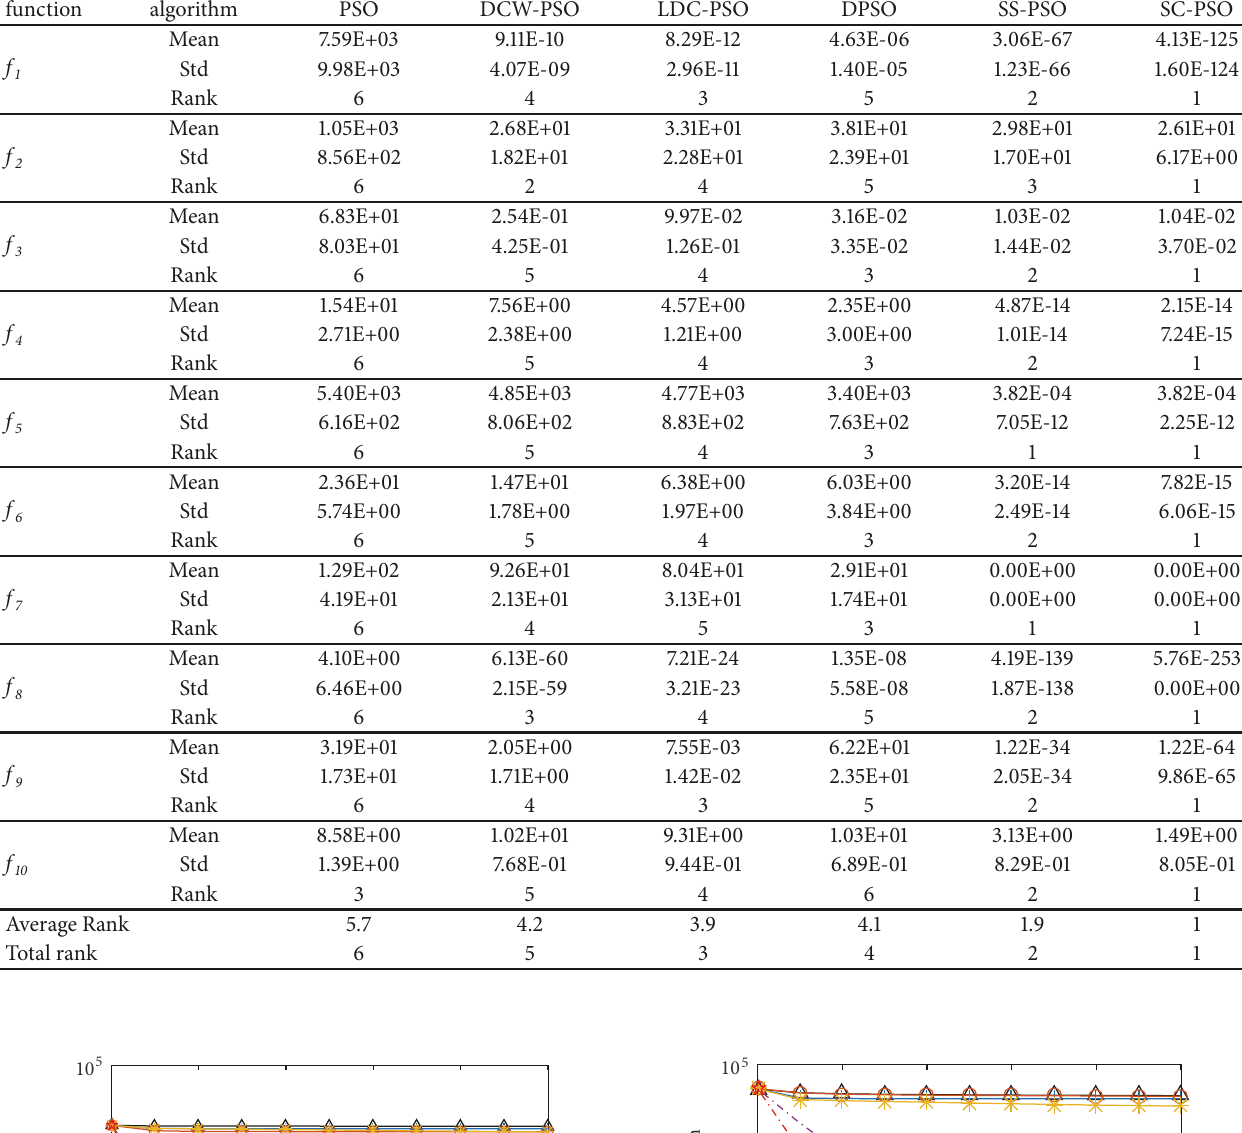
Table 2: Comparison of the optimization results on benchmark functions (30D).